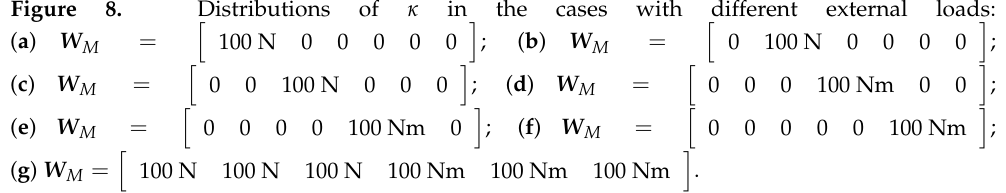
( g ) Figure 8. Distributions of  in the cases with different external loads: ( a ) Figure 8. Distributions of κ in the cases with different external loads: ( a ) W M (cid:104) (cid:105) ; 0 0 0 0 0 100 Nm (cid:104) (cid:105) ( g ) W M = . 100 N 100 N 100 N 100 Nm 100 Nm 100 Nm The elastostatic stiffness performance above can also be related to the singularity of the PM. The stiffness performance of the PM in the singular configuration can be clearly described by using the above stiffness indices under single external loads. In [32], it has been proved that the redundantly actuated 2UPR–2PRU PM is in the inverse kinematic singular configurations when the link B 3 A 3 or B 4 A 4 is parallel to the x -axis. Using the link parameters and operational height above, the 2UPR–2PRU PM reaches the singular configurations when β = − 40 ◦ or β = 40 ◦ , which have been highlighted in pink in the top- left quarter of each distribution, as shown in Figure 8a–f. In Figure 8a–c, the 2UPR–2PRU PM under the singular configurations has better stiffness performance when the single external force is along the x -axis. However, the stiffness performance of the PM is poor when the single external force is along the y - or z -axis. In addition, the 2UPR–2PRU PM under the singular configurations has poor stiffness performance when a single external couple is applied on the moving platform, no matter in what direction, as shown in Figure 8d–f. To summarize, the 2UPR–2PRU PM with redundancy actuation has relatively good resistance to a single external force along the x -axis in singular configurations. Compared with the values of the stiffness index under the external force along the x -axis, these values under other external forces or couples are so small and can be approximated as zero. It should be noted that although the stiffness model developed in this study is a simple one with some assumptions, the above results can provide references for avoiding singular configurations and selecting the suitable workspace. The distributions of κ under a combined external load in the different operational heights are also discussed in this paper. Figure 9a–d shows the distributions of κ in the different (cid:2) (cid:3) operational heights when W M = . 100 N 100 N 100 N 100 Nm 100 Nm 100 Nm The stiffness performance becomes worse with the increase of the operational height. Under this external load, the redundantly actuated 2UPR–2PRU PM has a better stiffness (cid:2) − (cid:3) (cid:2) − (cid:3) performance in the orientation ranges where β ∈ and γ ∈ , and 40 ◦ , 0 ◦ 40 ◦ , − 20 ◦ (cid:2) − (cid:3) (cid:2) (cid:3) β ∈ and γ ∈ . To demonstrate the superiority of the mechanism 40 ◦ , 0 ◦ 20 ◦ , 40 ◦ stiffness in the selected orientation ranges, the minimum, maximum, and average values of the stiffness index in the above selected ranges and other ranges are listed, as shown in Table 4. It can be seen that in the different operational heights, the minimum,